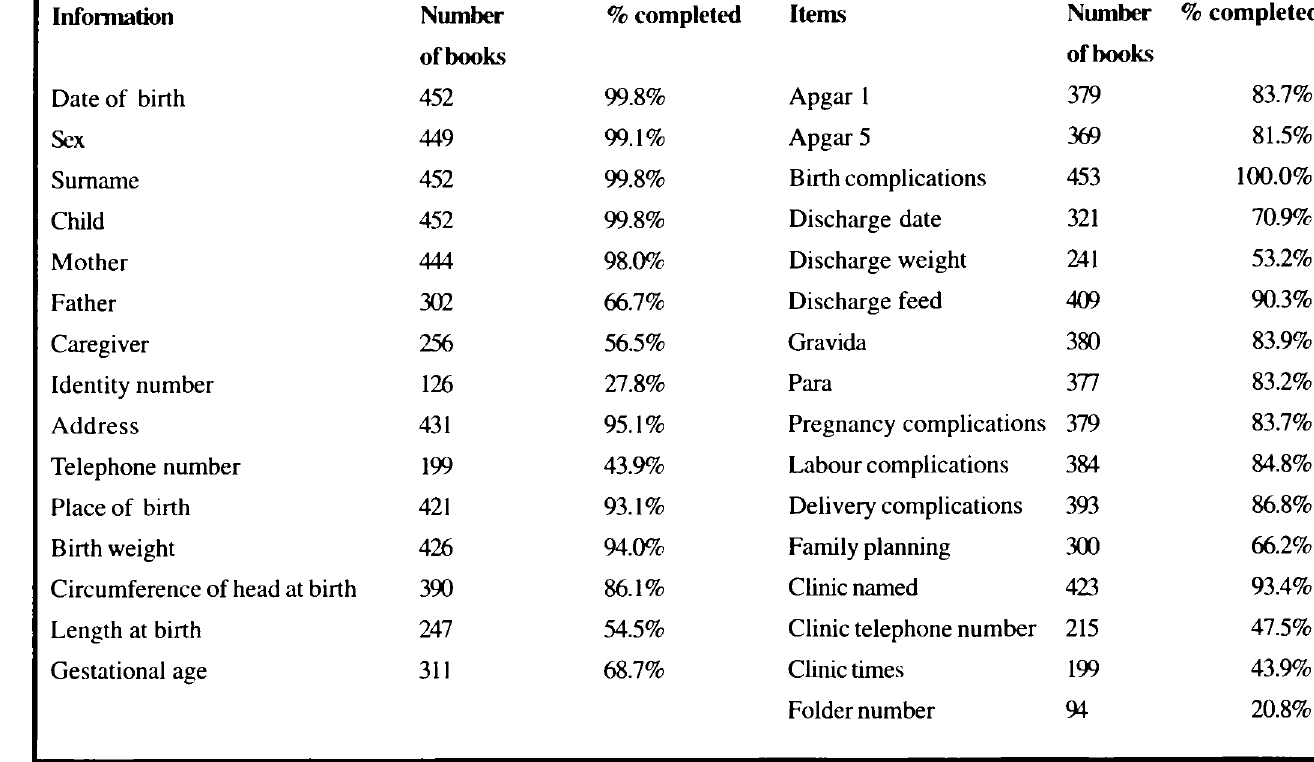
Table II: Information extracted from 453 RTH books completed by nurses, clients and researchers.